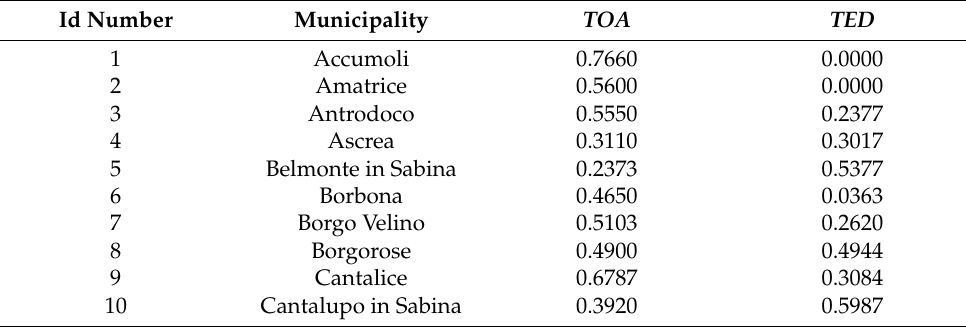
Table 4. Tourism attractiveness and territorial development: scores of the municipalities. Author’s own